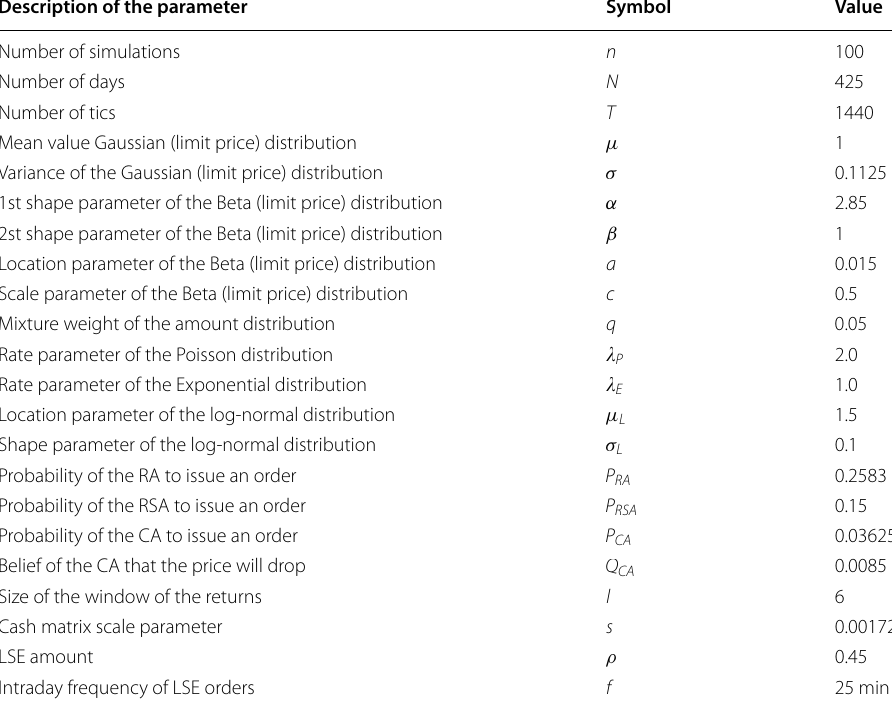
Table 3 Parameters of the model Description of the parameter Symbol Value Number of simulations n 100 Number of